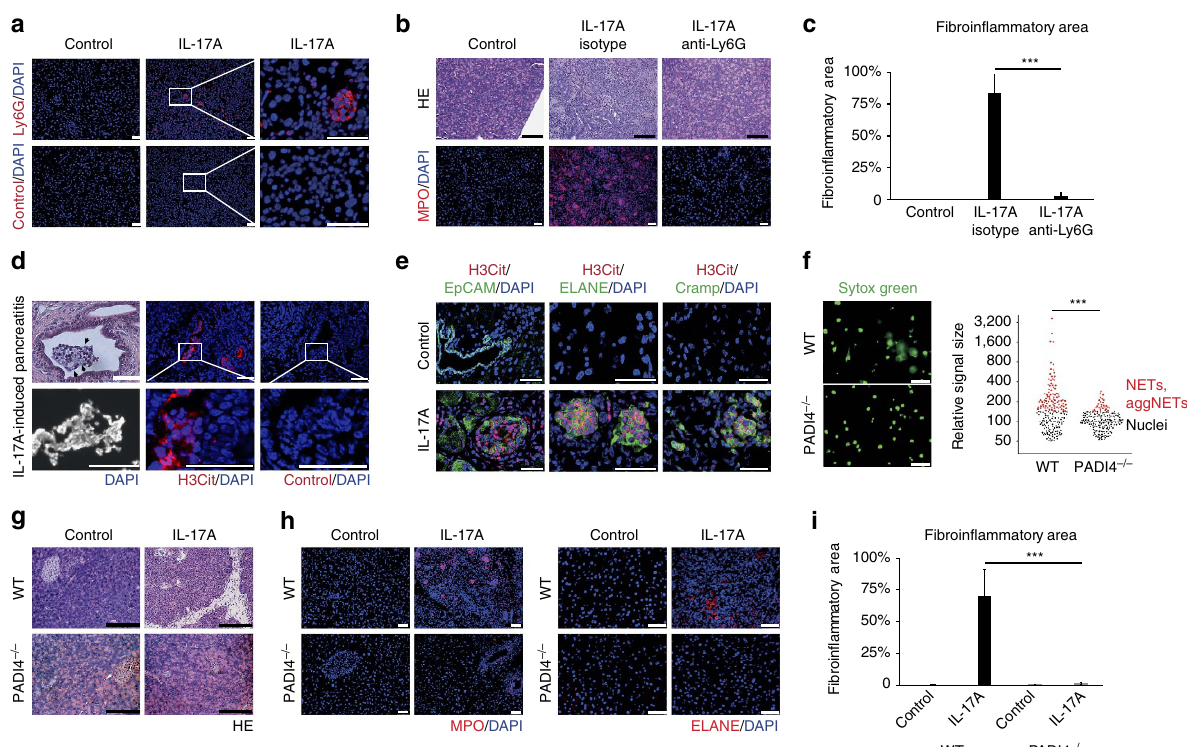
Figure 2 | IL-17A-induced pancreatitis is driven by PADI4-dependent neutrophil aggregates. ( a ) Ly6G immunohistochemistry detected neutrophil granulocyte aggregates in the pancreas after IL-17A challenge only. ( b , c ) Mice treated with IL-17A delivery or control were injected with a neutrophil- depleting anti-Ly6G antibody (1A8) or isotype control (2A3) (three independent experiments with n ¼ 12 per group, *** P o 0.001 (analysis of